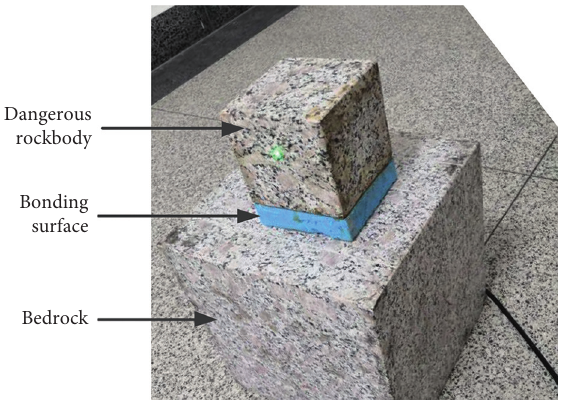
Figure 4: Schematic of indoor test process.